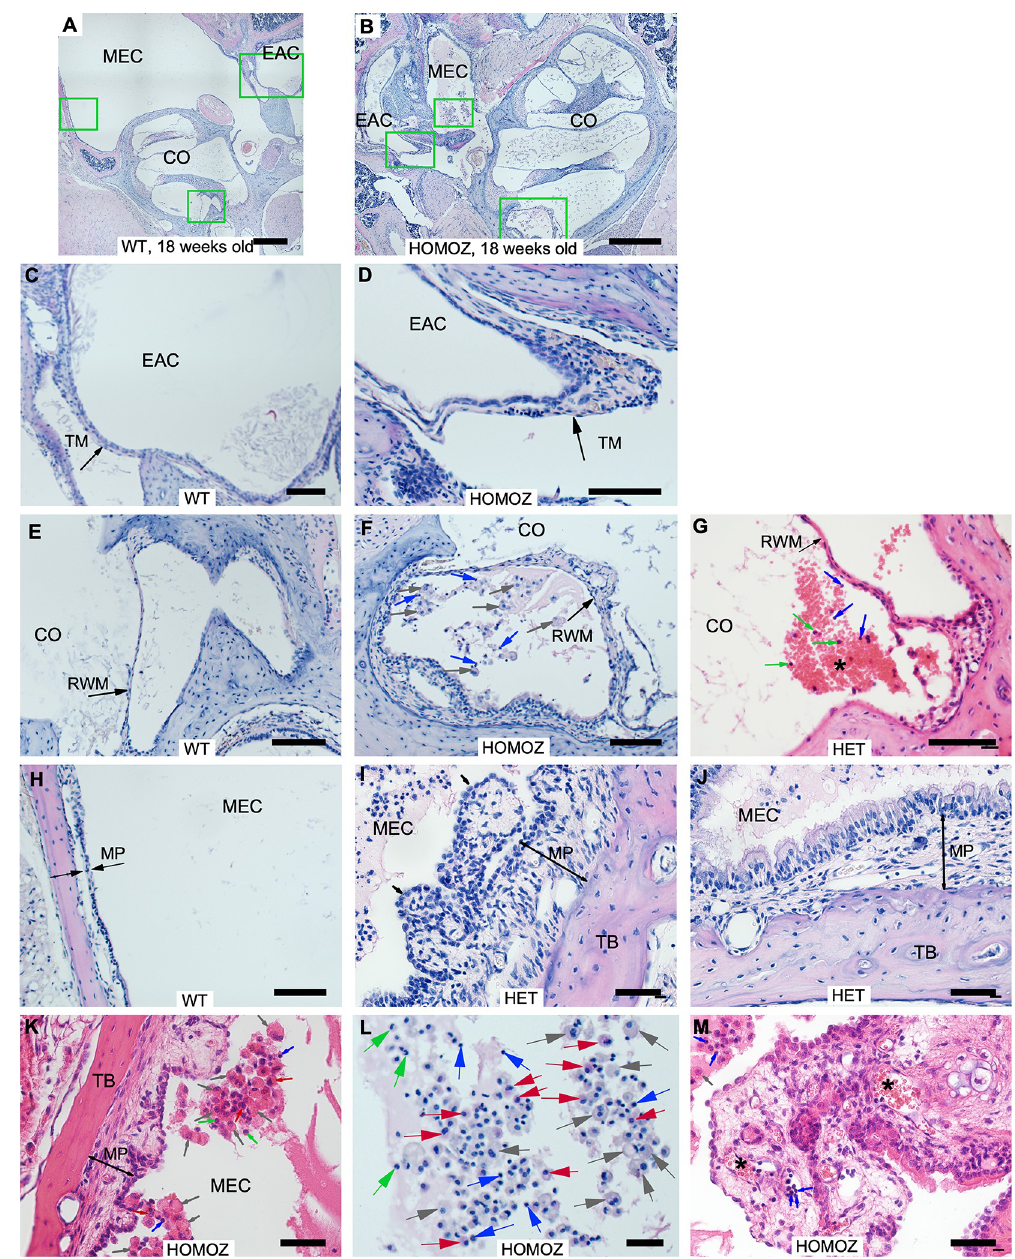
Fig 3. Morphological changes of STAT1-KO mice. (A-B) Representative images from middle ears of 18 weeks old wild type and STAT1-KO mice. Scale bars 500 μ m. (C, E, H) High magnification images of wild type mice (A). (D, F, L) High magnification images of STAT1-KO mice (B). Scale bars in D and F 100 μ m, in L 10 μ m. (C, D) The thickness of the tympanic membrane (TM) was greater in STAT1-KO mouse compared to wild type mouse. (E-G) The round window membrane (RWM) of STAT1-KO was thicker than the membrane of wild type mice. (H-K) The thickness of mucoperiosteum (MP) of knockout mice containing epithelial hyperplasia and fibrous polyps (black arrows) was much greater compared to MP of wild type mice. Scale bars in I, J, K 50 μ m. Different manifestations of inflammatory cell infiltration were observed in STAT1-KO mice (F, G, I, J, K, M). (G) In addition, cluster of erythrocytes ( � ) was also detected. Scale bar 50 μ m. (L) Representative image of a middle ear cavity (MEC) of knockout mouse that was partially filled with exudate comprising inflammatory cells such as macrophage as single or multinucleated (grey arrow), lymphocytes (blue arrow), neutrophil (green arrow), eosinophil (red arrow). (M) MEC from a mouse showing disruption of ciliated epithelium with fibrous proliferation and clusters of lymphoid infiltrates (arrows) and cluster of erythrocytes ( � ). Scale bar 50 μ m. CO, cochlea; HET, heterozygous; HOMOZ, homozygous; TB, temporal bone; WT, wild